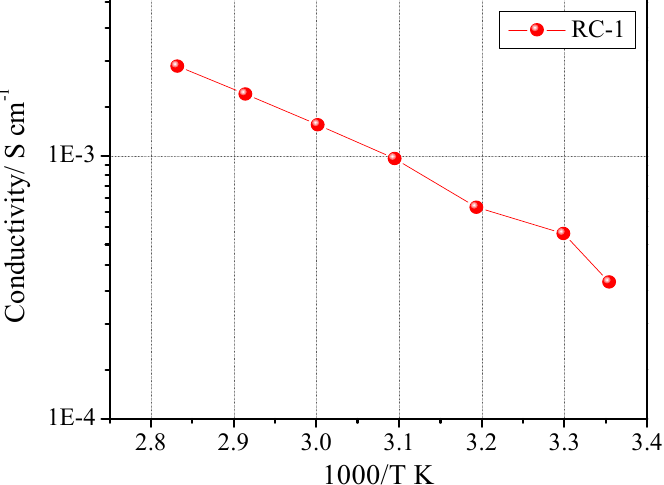
Figure 3. Ionic conductivity vs . temperature plot of sample RC-1. Data obtained by impedance